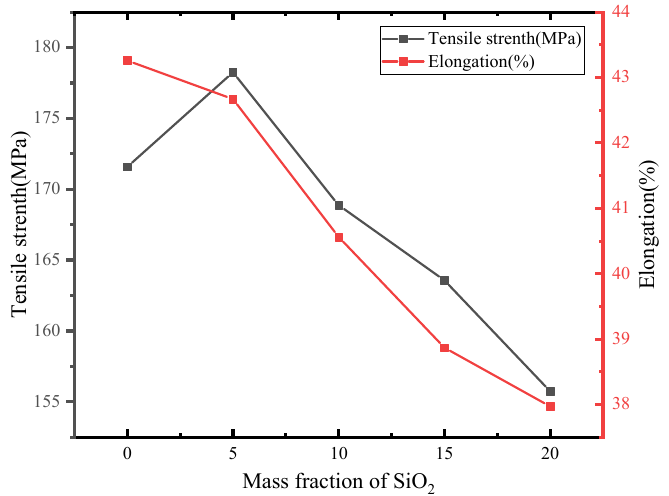
Figure 6. Tensile strength and elongation of pure PI film and PI/nano-SiO 2 three-layer composite film with different doping amounts.